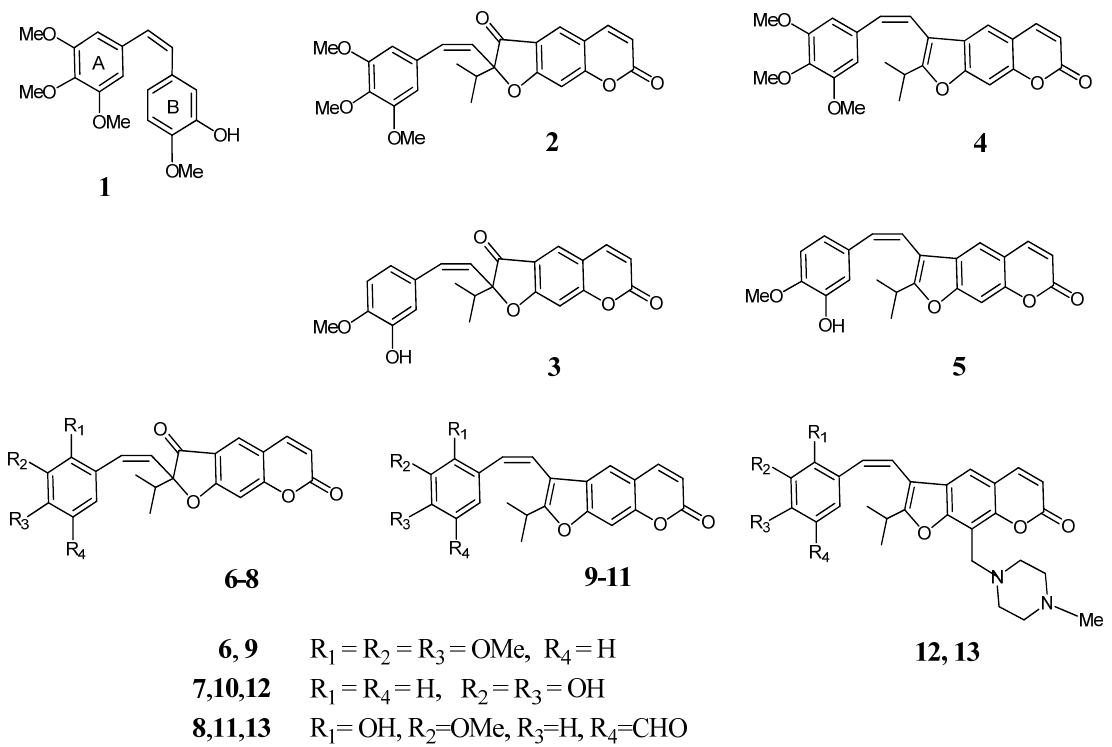
Figure 1. Structures of combretastatin A-4 ( 1 ) and furocoumarin analogs of combretastatins 2 – 13